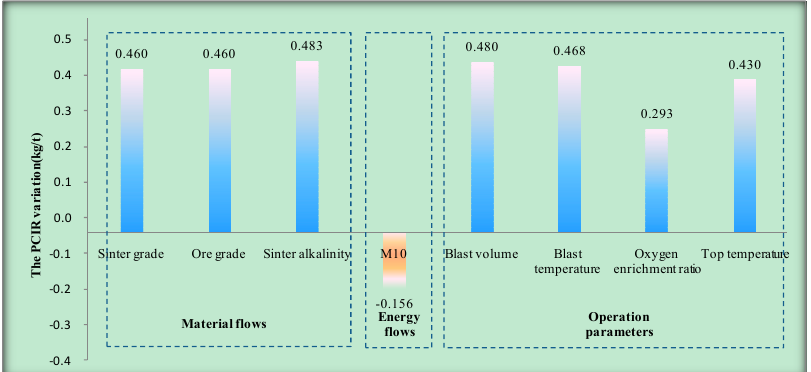
Figure 8. The influence intensity of significant factors on PCIR.